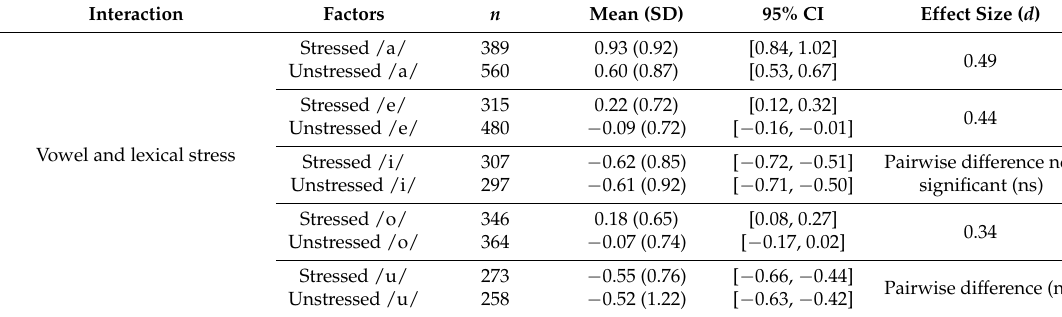
Table 2. Descriptive results for normalized F1